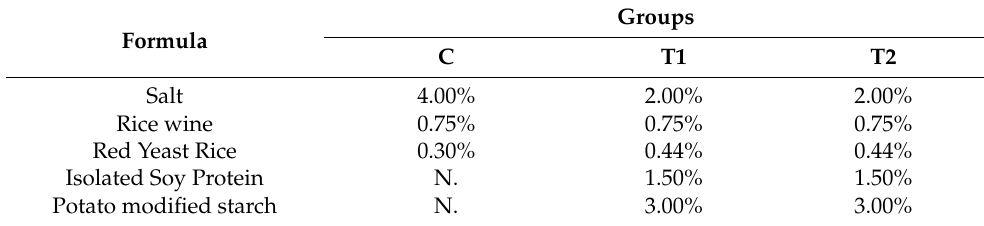
Table 1. Sample preparation process formula table of